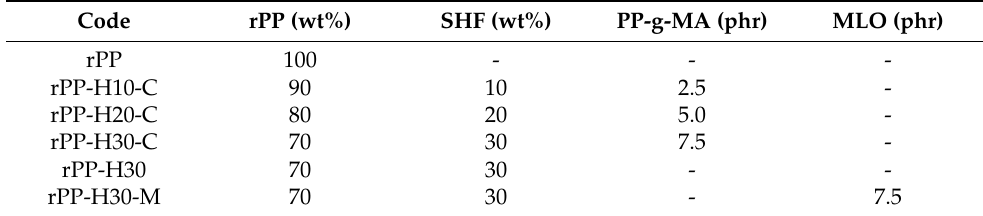
Table 1. Coding and formulations of the rPP/hemp fiber composites with different compatibilizers.